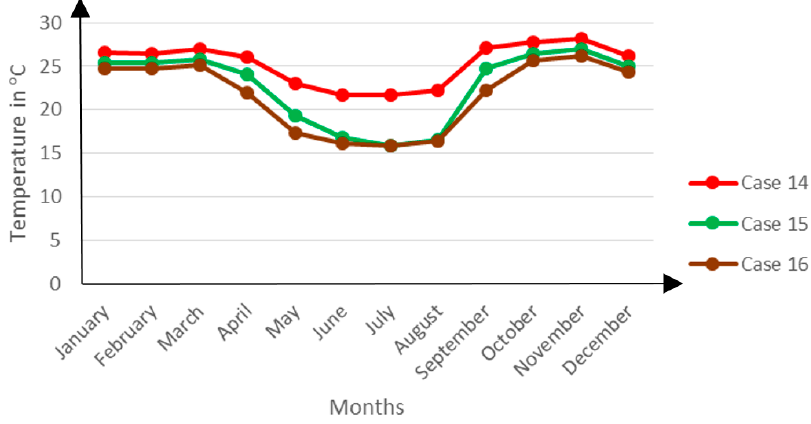
Figure 15. Monthly mean zonal temperatures for Cases 14, 15 and 16.